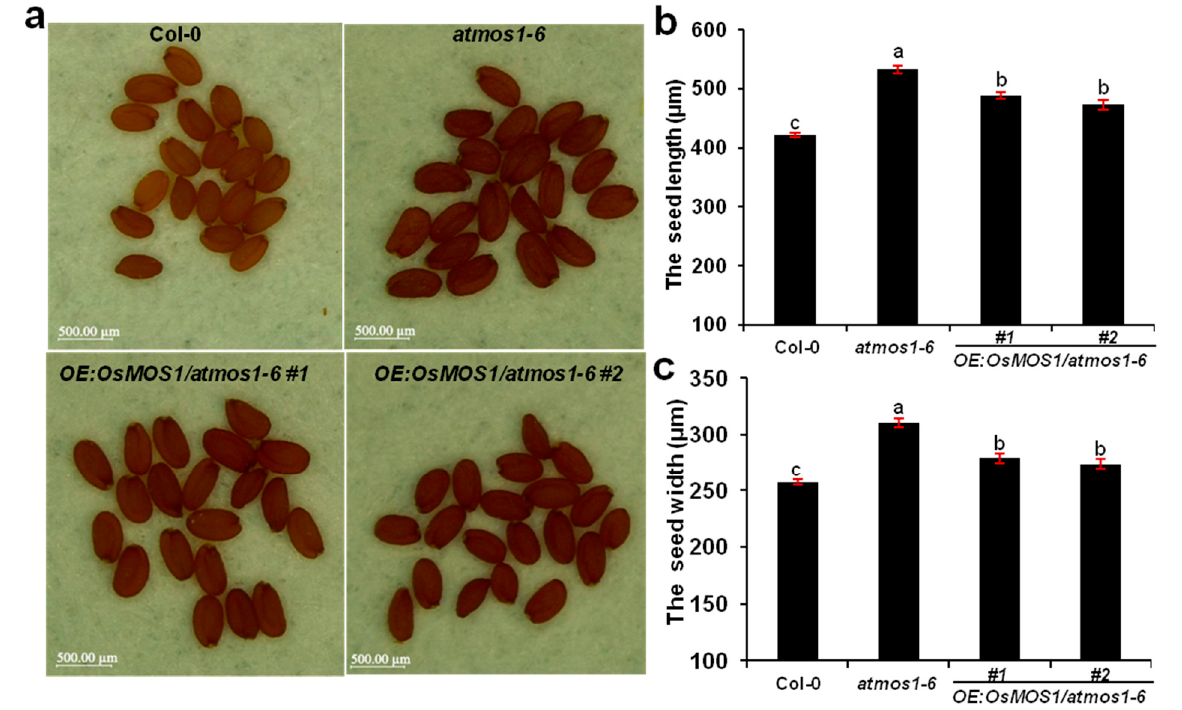
Figure 8. Analyses of seed size in Col-0, atmos1-6 , and OE:OsMOS1/atmos1-6 transgenic plants. ( a ) Seed morphology of Col-0, atmos1-6 , and OE:OsMOS1/atmos1-6 transgenic plants. Scale bars correspond to 500 μ m. ( b , c ) Statistical analysis of seed length ( b ) and seed width ( c ) in Col-0, atmos1-6 , and OE:OsMOS1/atmos1-6 transgenic plants. Error bars indicate the standard deviation, n = 3 × 500. Different letters indicate significant differences based on Duncan’s multiple range test among the means via ANOVA ( p < 0.05). The cell length and width were determined by averaging the results for three replicates (each replicate consisted of at least 30 cells).